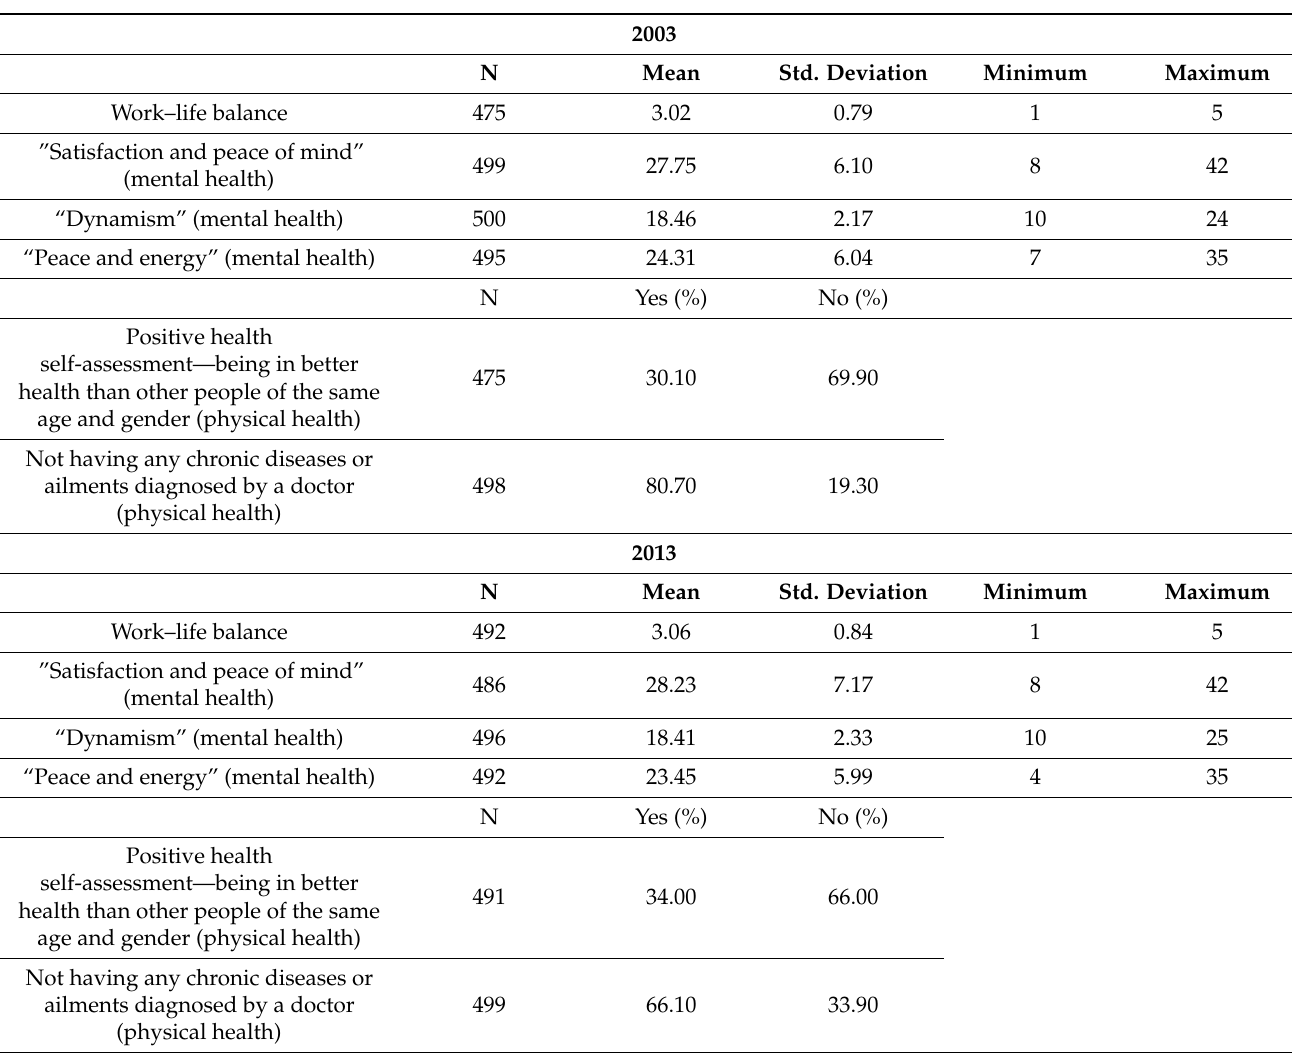
Table 1. Descriptive